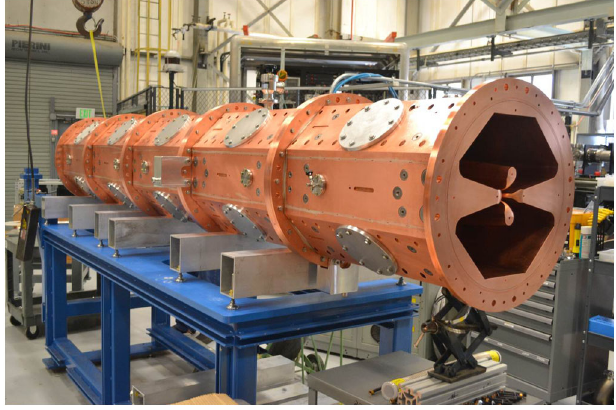
FIG. 9. Completed assembly of the five-segment RFQ.